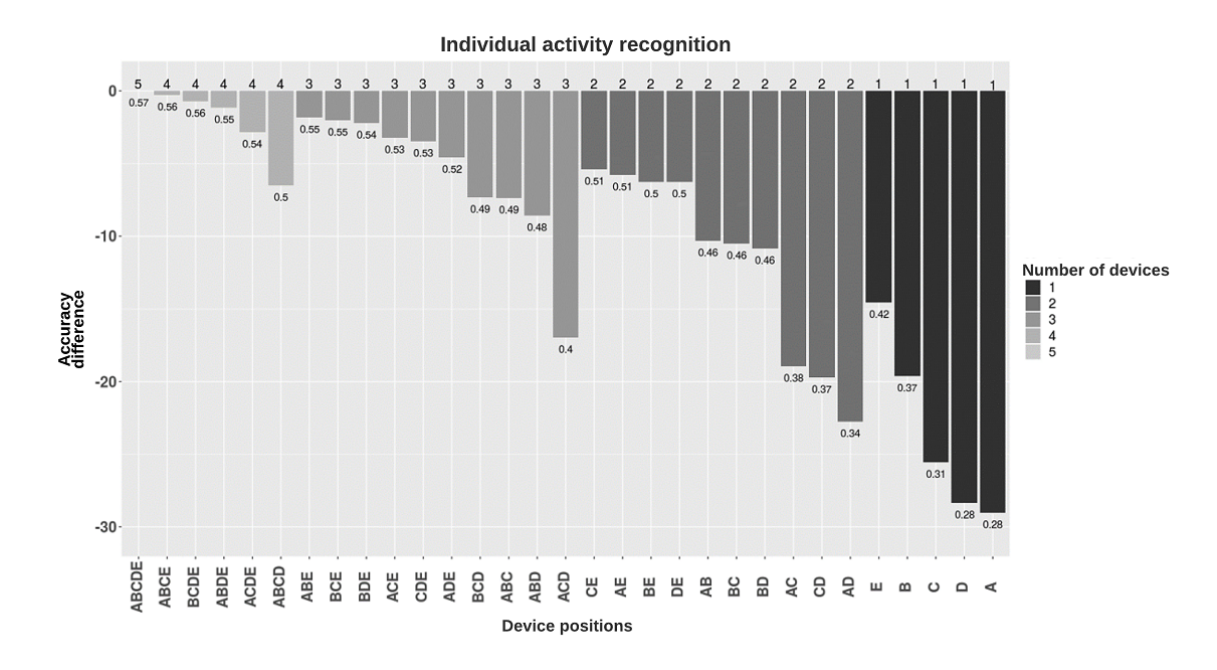
Figure 6. Accuracy performance of individual activity classification models based on the device placement combinations. Models were grouped by the number of devices used and, in each group, were sorted in decreasing accuracy (rounded). Y-axis shows the difference between the accuracies of the different combinations and the five-placement combination. Numbers in the plot show the accuracy of each placement combination. A: ankle; B: upper arm; C: hip; D: thigh; E: